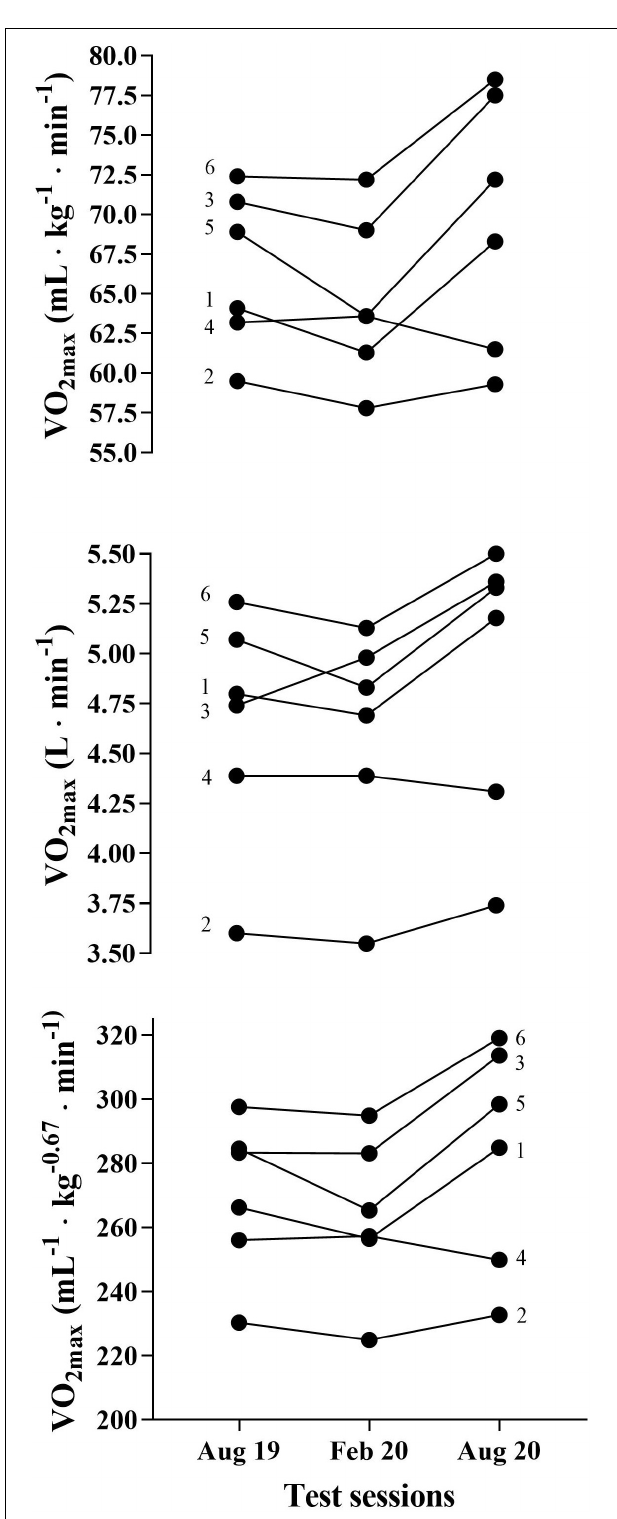
FIGURE 1 | Development of VO 2max from August 2019 to August 2020. VO 2max , maximal oxygen uptake; ml · kg − 1 · min − 1 , milliliters per kilogram bodyweight per minute; L · min − 1 ; liters per minute; ml · kg − 0 . 67 · min − 1 , milliliters per kilogram bodyweight raised to the power of 0.67 per